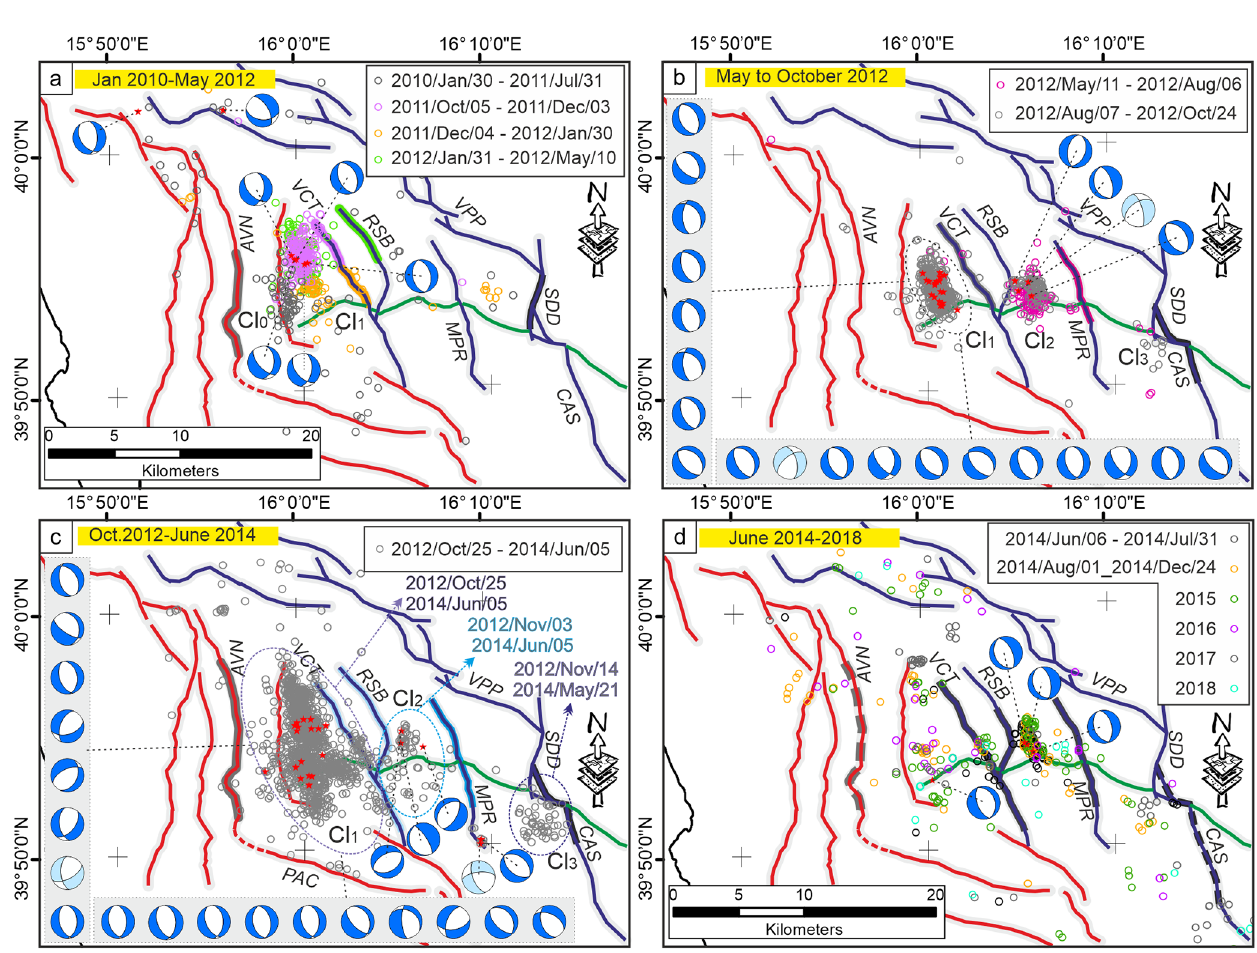
Figure 4. Time–space evolution of the 2010–2018 seismic activity in the Pollino area. Each panel shows the distribution of focal mechanisms (Totaro et al., 2015, 2016) and epicenters concentrated in a series of neighboring clusters numbered as Cl 0, 1, 2, and 3 from west to east, according to their activation time. See Sect. 5.2 for the sequence description. The focal mechanisms are classified following Frohlich (2001) kinematics classification (blue beach ball: normal kinematics; light blue: normal strike kinematics). Small red circles represent the epicenters of focal mechanism